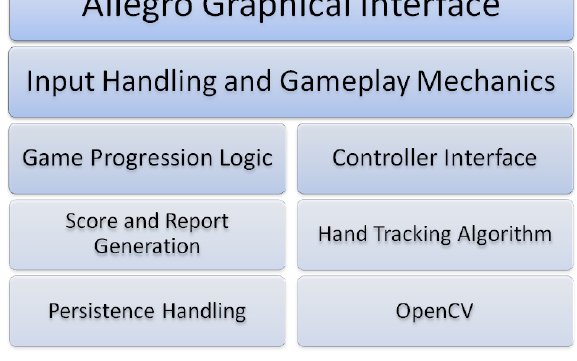
Fig. 3: The Handcopter Game architecture.